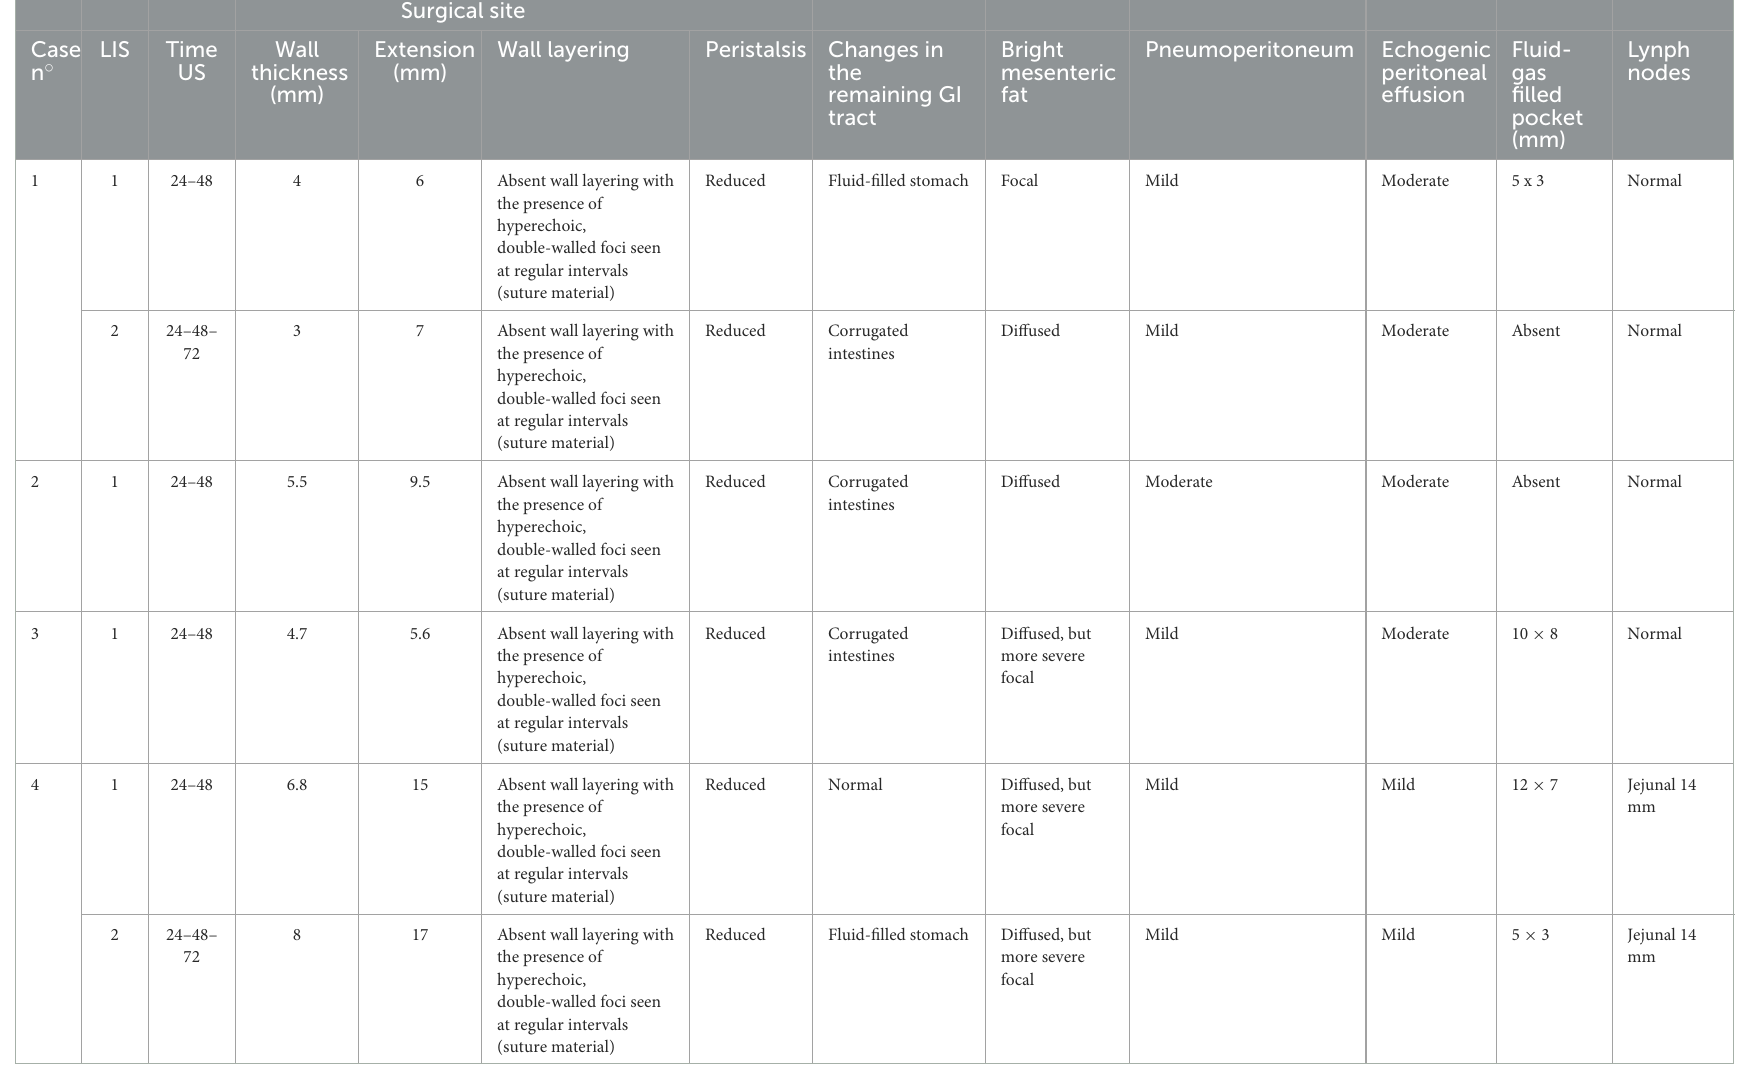
TABLE 3 Ultrasonographic findings observed in each dog at the time (24, 48 h…..) the ultrasound was performed before the time of diagnosis of leakage of intestinal sutures (LIS) after intestinal